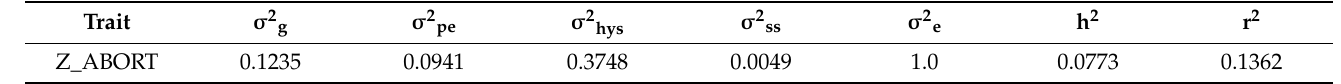
Table 2. Estimated variance components for abortion in Holsteins.